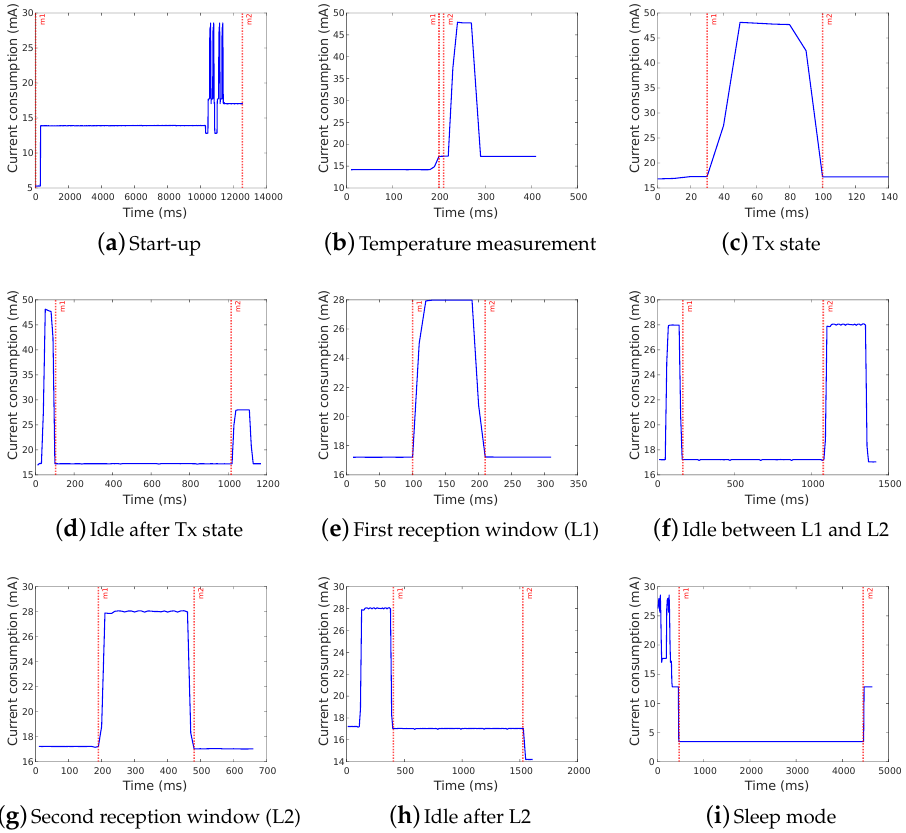
Figure 6. Measured current consumption for different states of the LoRaWAN device.